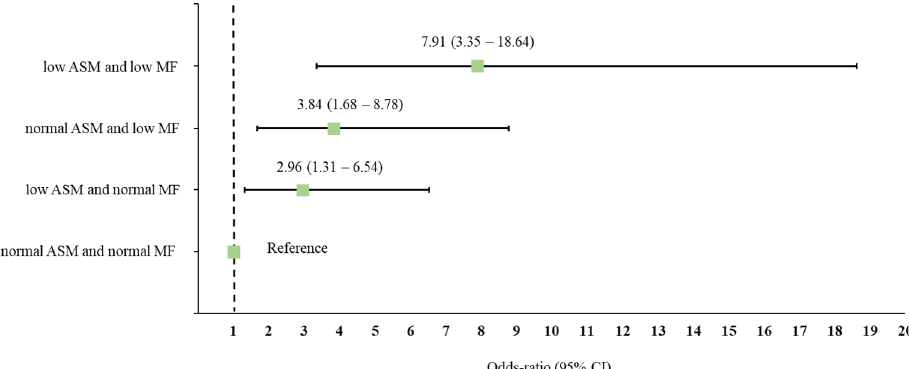
Figure 2. Odds ratio (OR) and 95% confidence interval (CI) for depressive symptoms according to appendicular muscle mass (ASM)- and muscle function (MF)-based subgroups. ORs were adjusted for covariates, including age, education, body mass index, waist circumference, medications, alcohol intake, smoking, physical activity, handgrip strength, and agility performance.